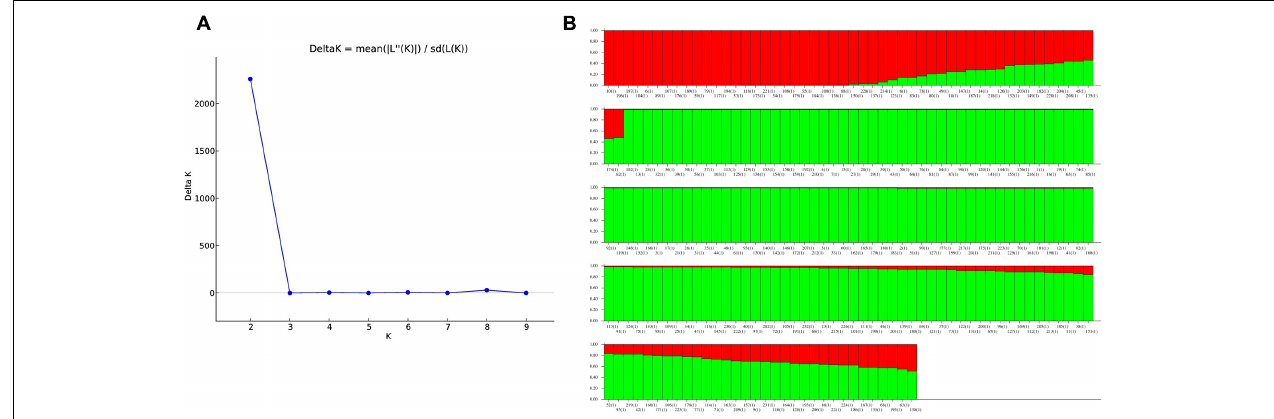
FIGURE 5 | Representation of population structure dividing the landraces in two subgroups based on K value (A,B) . Landraces with > 80% probability are assigned to corresponding subgroups and exceptions are shown as an admixture. (A) Population structure inferring the landraces divided into two subgroups based on K value. (B) Population structure inferring the landraces divided into two subgroups based on K value. Landraces with probability > 80% were assigned to corresponding subgroups and remaining as an admixture.